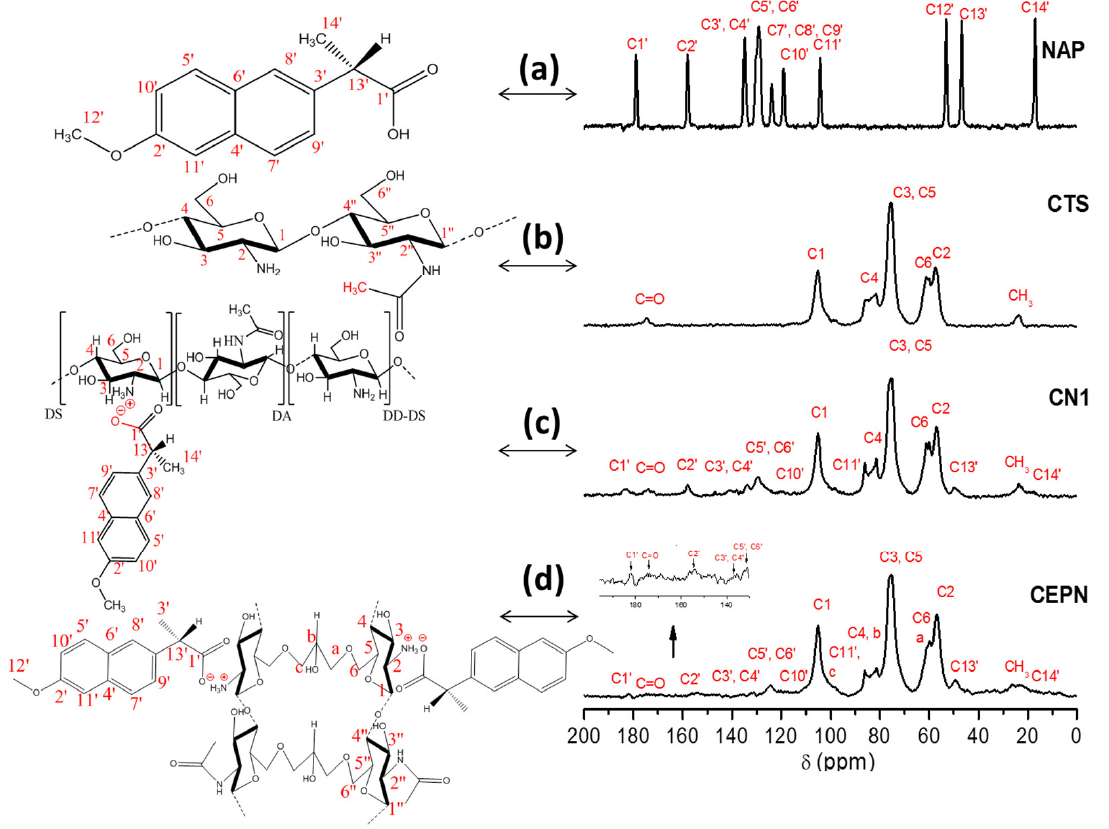
Figure 1. 13 C NMR spectra of reagents and reaction products: ( a ) NAP, ( b ) CTS, ( c ) CN1, ( d ) CEPN, and the structural formula identifying the carbon atoms for assignments.